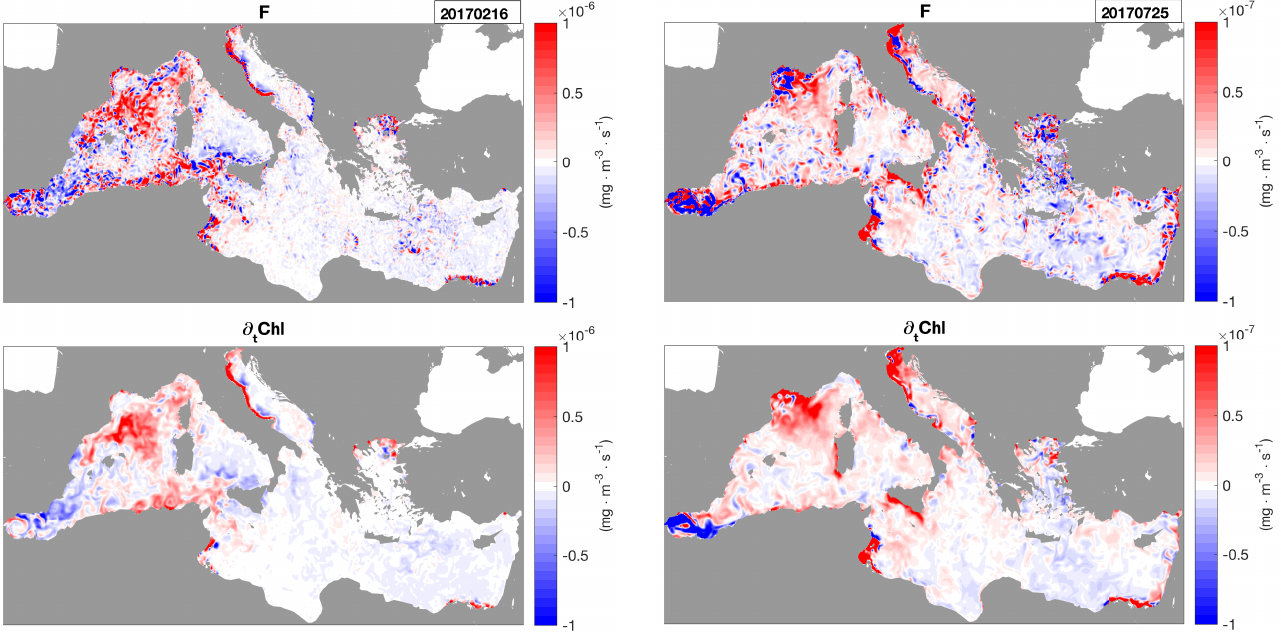
Figure 15. ( Left ) Top panel represents the F term computed by means of Equation (3). The bottom panel shows the surface Chl temporal derivative on 16 February 2017. ( Right ) same analyses reproduced on 25 July